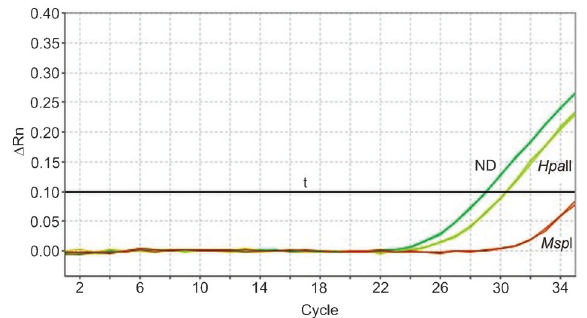
Figure 1. Amplification plot obtained by the StepOne system software using Method II. ND: non-digested sample; Hpa II: sample digested with Hpa II, a methylation-sensitive restriction enzyme; Msp I: sample digested with Msp I, an isoschizomer of Hpa II, which is insensitive to methylation; t: